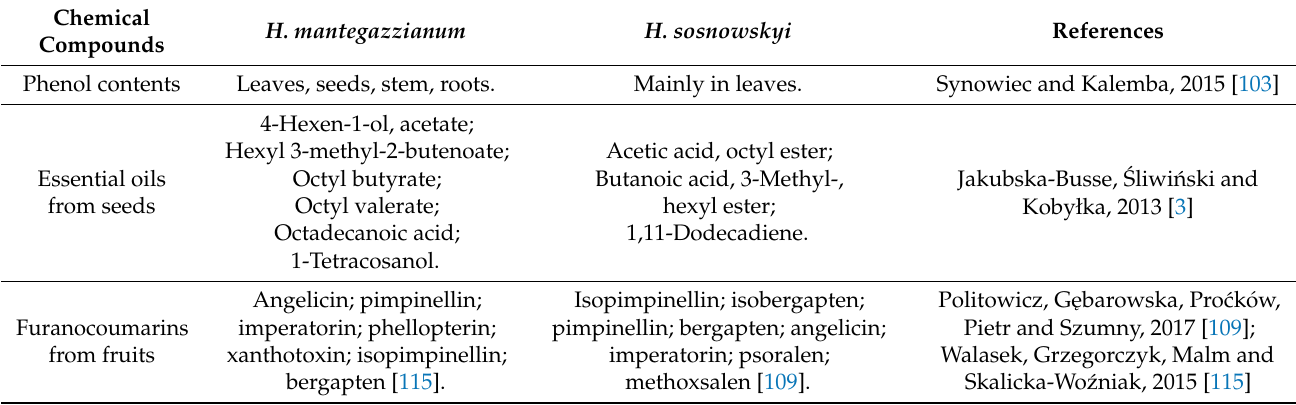
Table 2. Examples of the research results from Poland that showed the most important differences in the crucial chemical compounds of the two described Caucasian hogweeds. In the case of essential oils, only compounds individual for each weed were